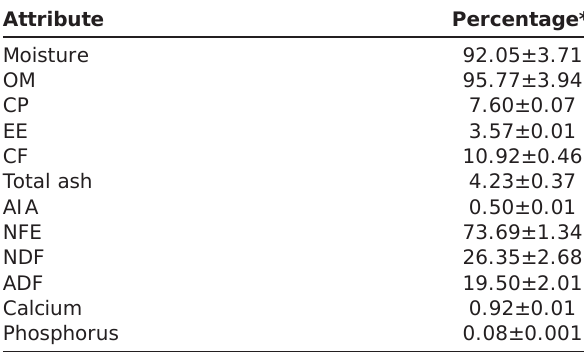
Table-2: Chemical composition of